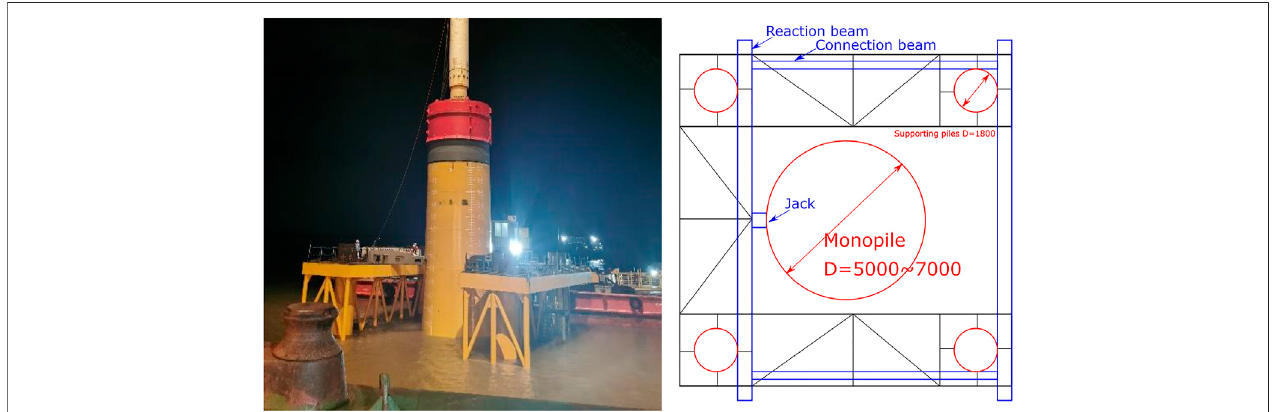
FIGURE 1 | The installation on site and the layout of the pile foundations (not scaled).